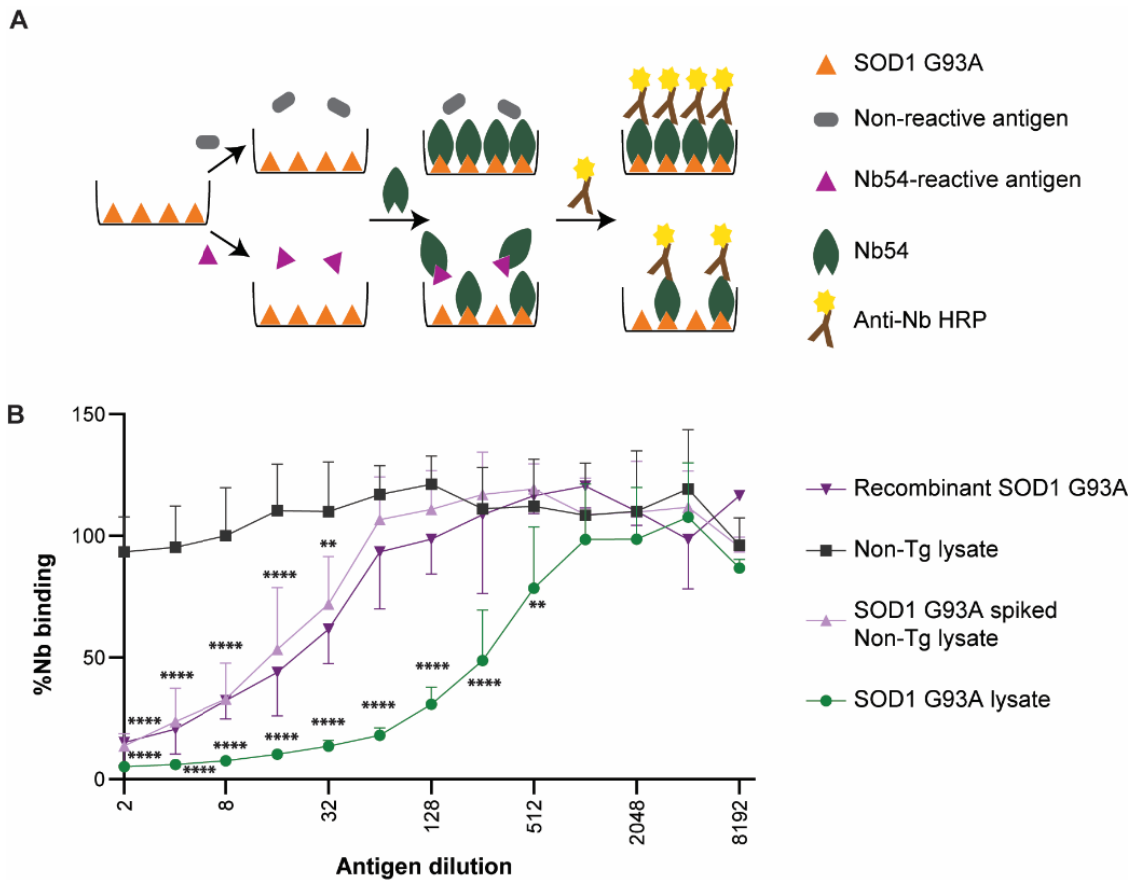
Figure 8. Nb54 detects SOD1 from spinal cord lysate of transgenic SOD1 G93A mouse. ( A ) A schematic representation of the competitive ELISA that was used to assess the competition of various antigens with SOD1 G93A for binding to Nb54. An antigen that is reactive to Nb54 is expected to reduce binding of Nb54 to SOD1 G93A, which is immobilized on the plate. ( B ) Spinal cord lysate from SOD1 G93A transgenic mice (green line) expressing both human SOD1 G93A and endogenous murine SOD1 WT competes with (i.e., reduces) Nb54 binding to immobilized SOD1 G93A in a dose-dependent manner, whereas lysate from non-transgenic (Non-Tg; dark grey) mice expressing only endogenous murine SOD1 WT does not. Dilutions of Non-Tg lysate (light purple) or buffer spiked with recombinant SOD1 G93A (0.2 µg/25 µL; dark purple) were used as positive controls for competition of Nb54 binding to immobilized SOD1 G93A. Error bars depict standard deviation among n = 4 animals per genotype. A two-way ANOVA was performed for all lysate samples followed by a Dunnett’s multiple comparison test to compare SOD1 G93A transgenic lysate or Non-Tg spiked with SOD1 G93A to the Non-Tg mouse lysate. ** p < 0.01, and **** p < 0.0001.